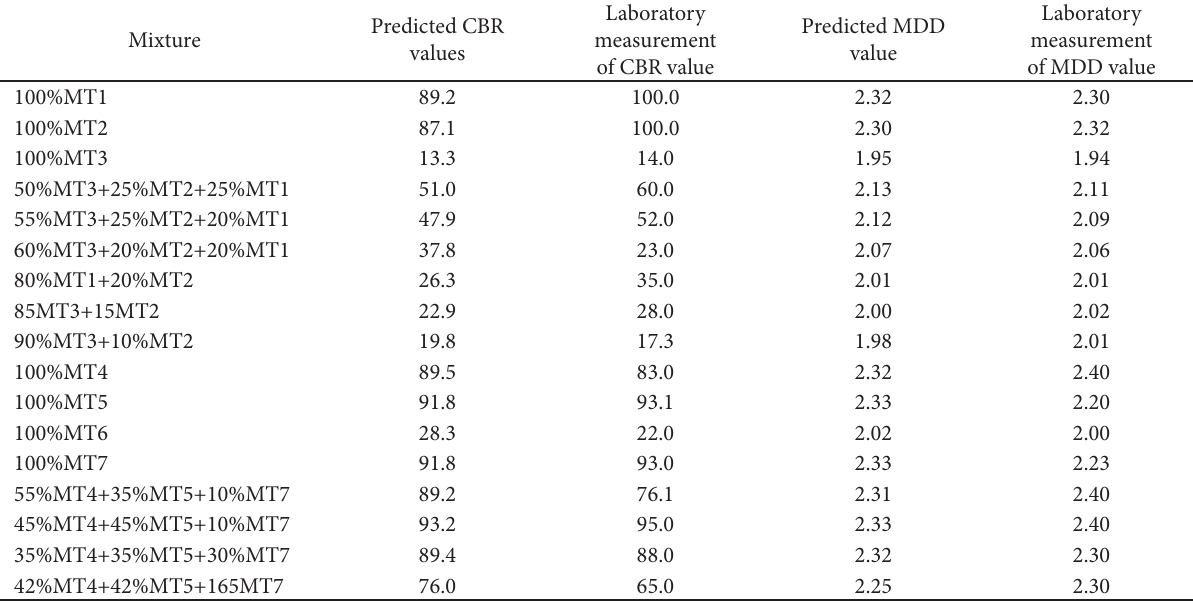
Table 5. Experimental and laboratory measurements for the CBR and MDD values